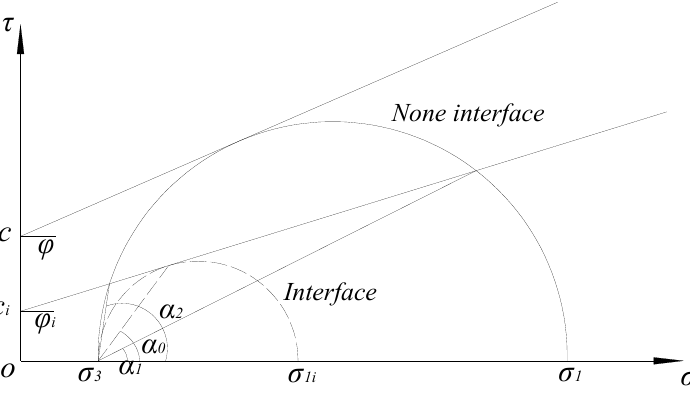
Figure 10. Strength envelope.